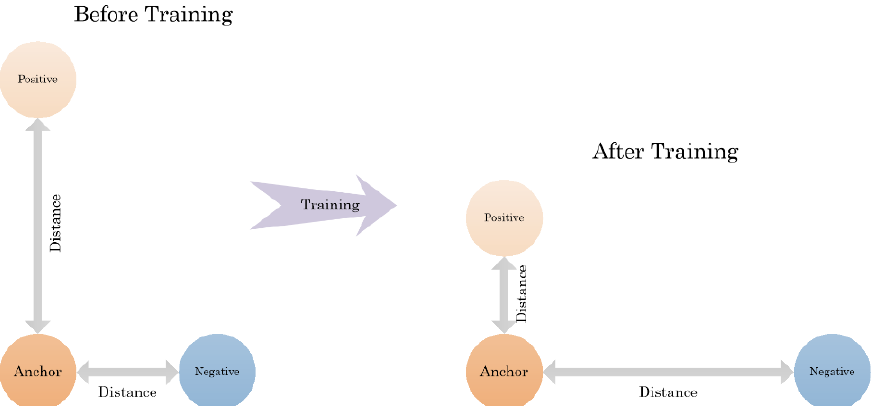
Figure 3. The goal of triplet learning.